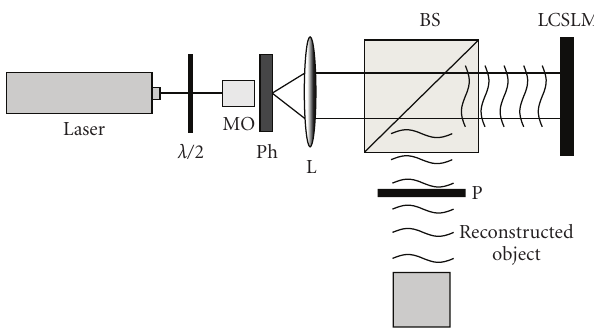
Figure 13: Scheme of setup for optical reconstruction with SLM, P: Polarizer, BS: Beam Splitter, Ph: Pinhole, and MO: Microscope Objective, L: Collimator lens, λ/ 2: Half-Wave Plate.